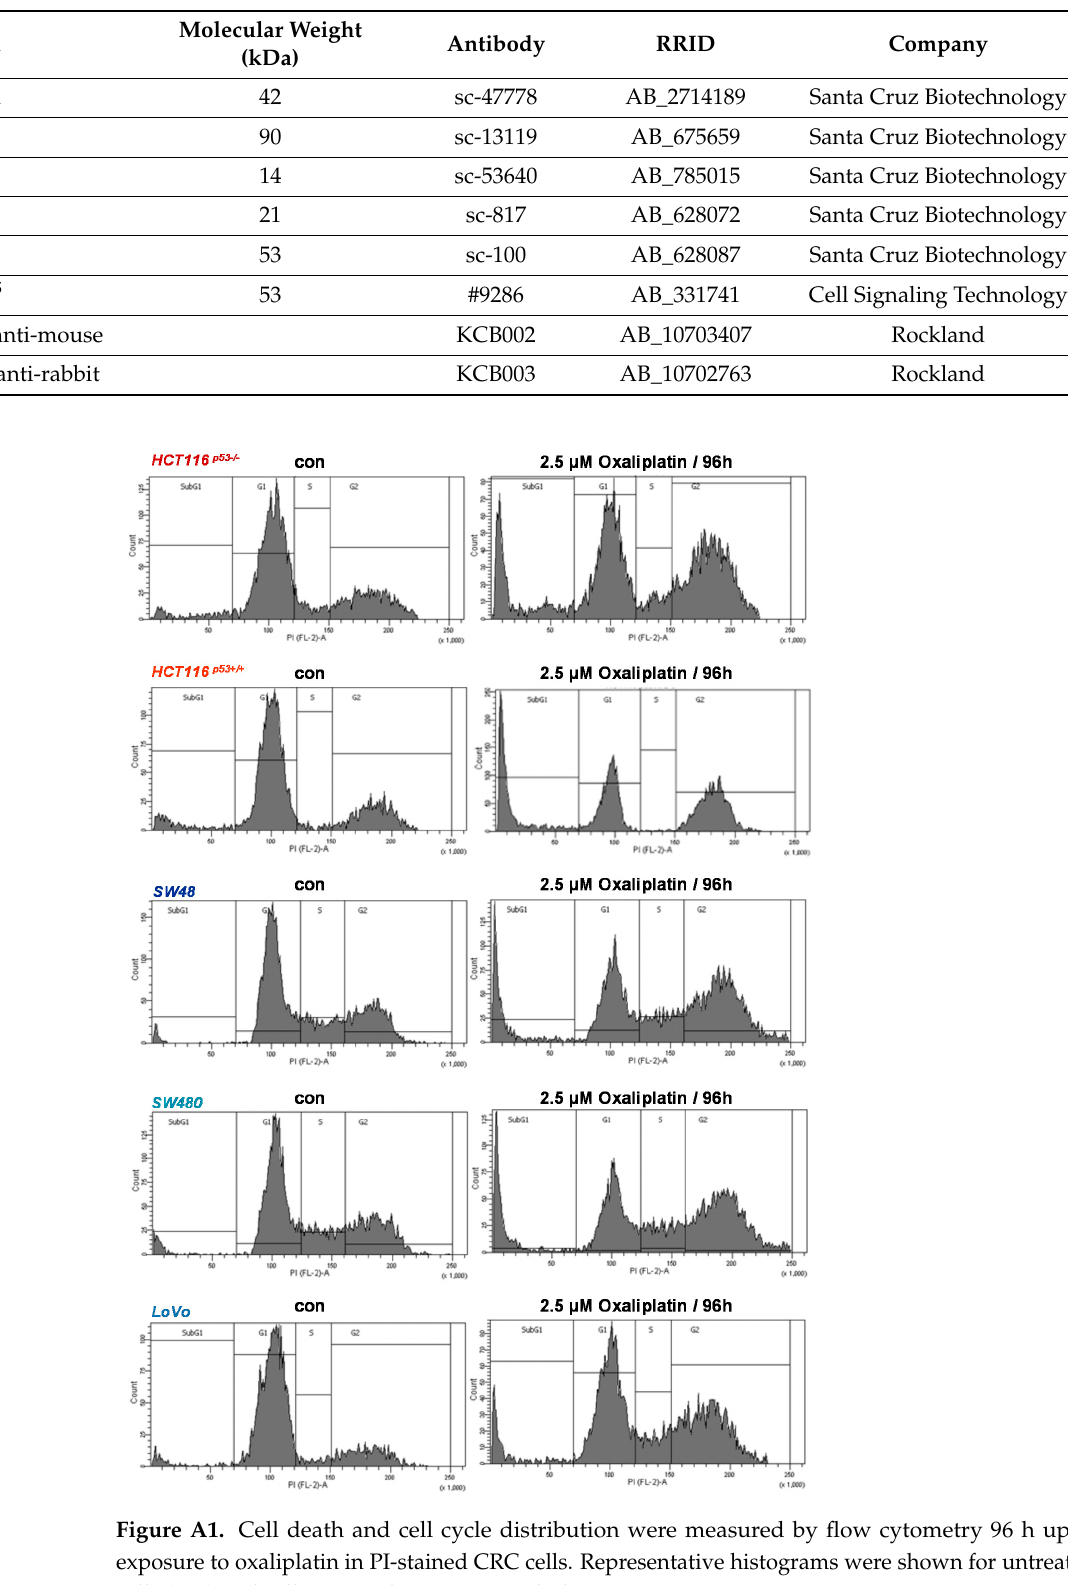
Table A2. Antibodies.